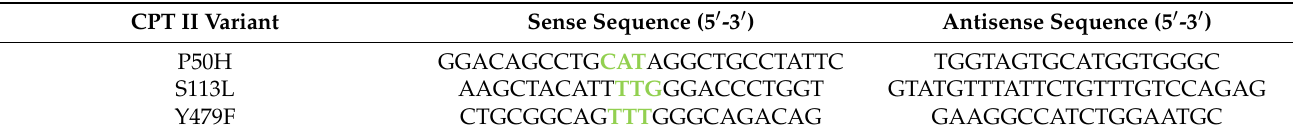
Table 4. Primer sequences for site directed mutagenesis. The nucleotide triplets of the amino acid exchanges of the respective variant are labelled green. CPT II